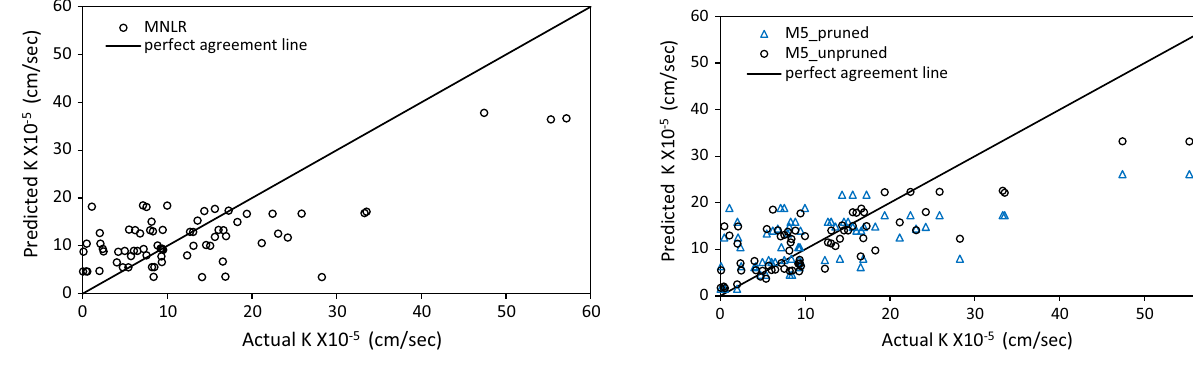
Fig. 5 Actual versus predicted values of hydraulic conductivity using M5 model tree (testing